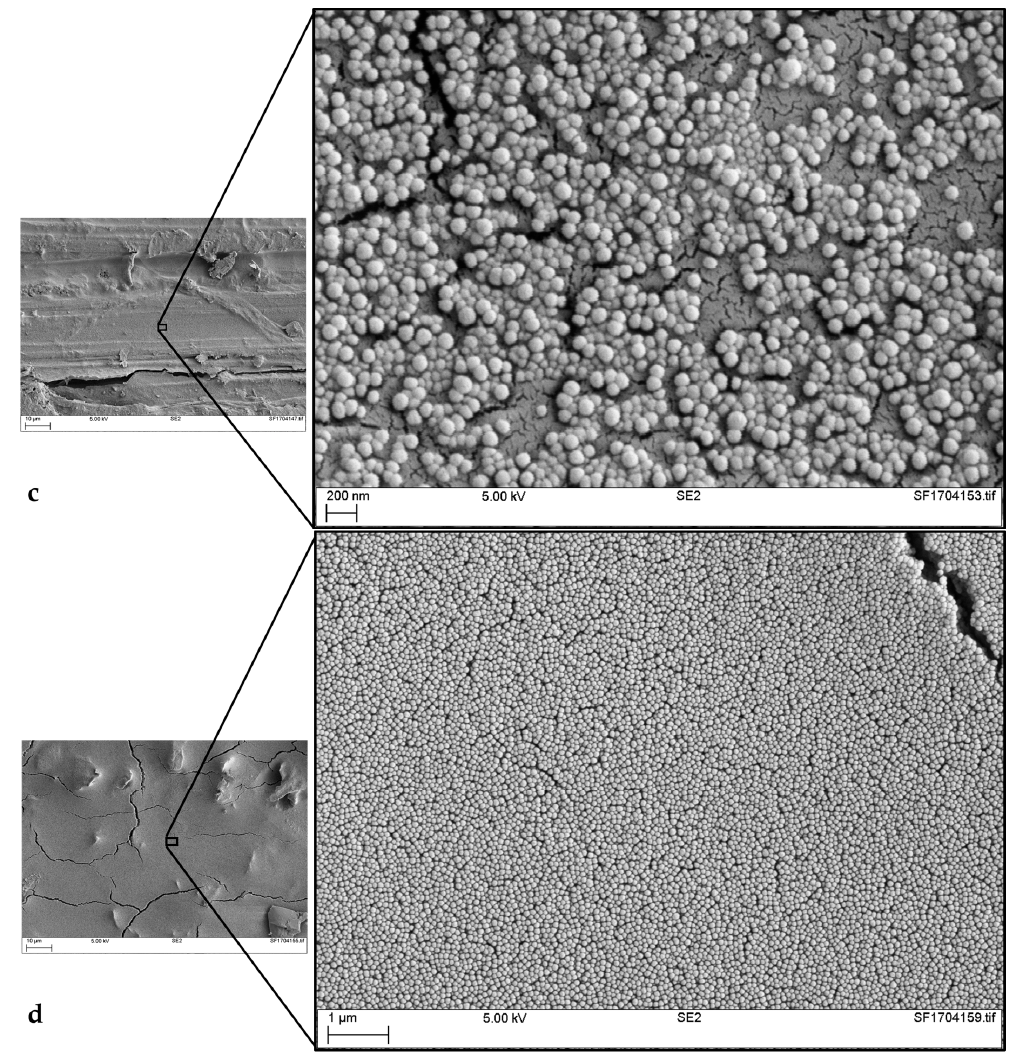
Figure 3. SEM (Scanning Electron Microscopy) images of samples: ( a ) H0-0-0 at ×10,000 magnification; ( b ) H12-1-1 showing a partial coverage at ×10,000 magnification; ( c ) H12-1-2 at ×25,000 magnification; and ( d ) H12-1-3 showing a complete and uniform coverage of the hemp shiv surface at ×10,000 magnification. Courtesy of TWI Ltd.